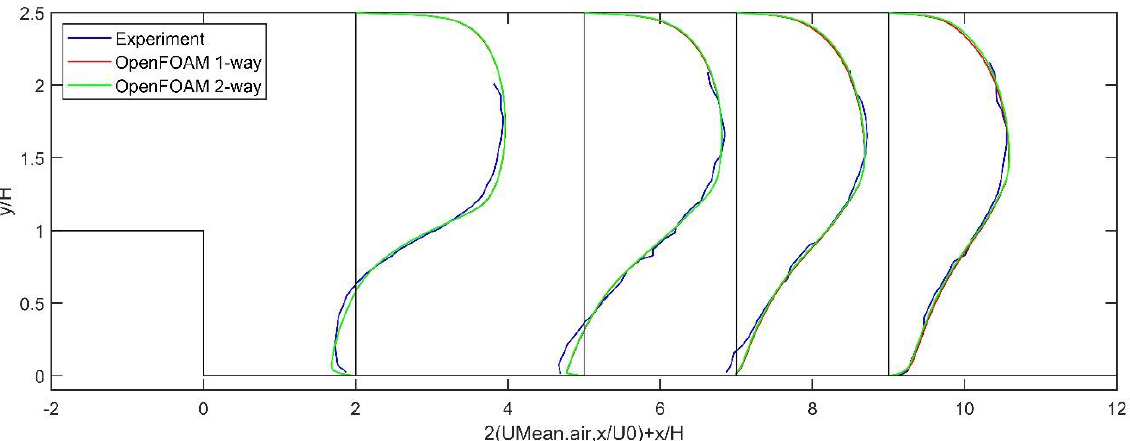
Figure 6. Comparisons of experimental and OpenFOAM simulated (RANS-DEM) streamwise air mean velocity profiles at the measurement locations for one-way and two-way coupling for the case corresponding to a particle injection velocity of 10.5 m/s. One-way coupling